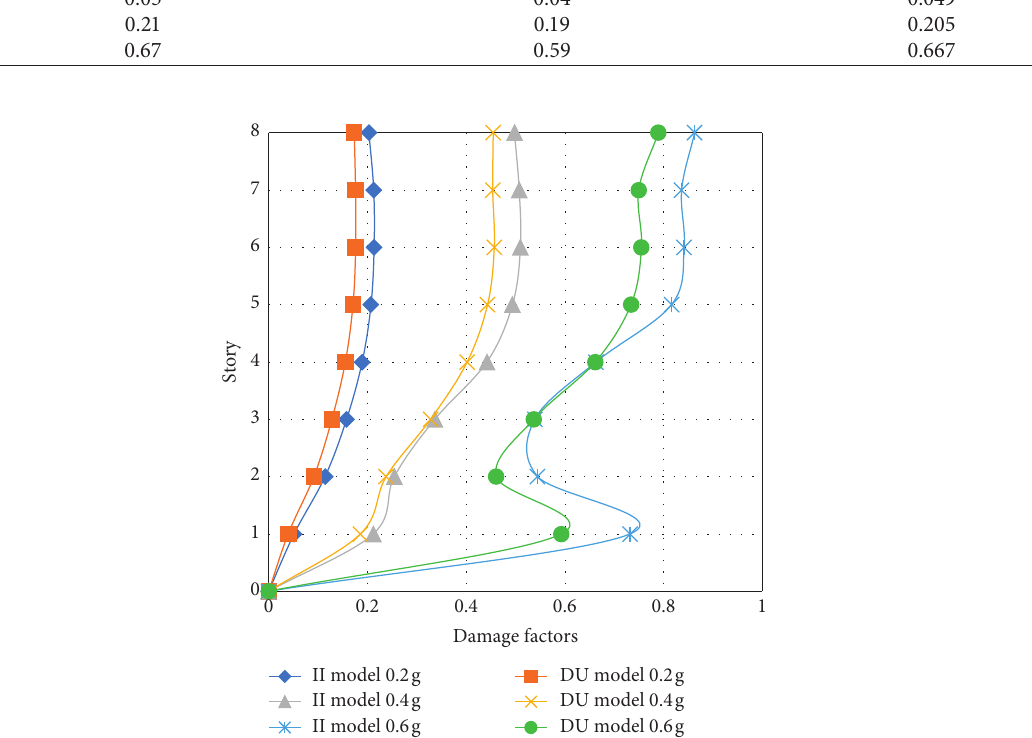
Figure 12: Comparison of damage